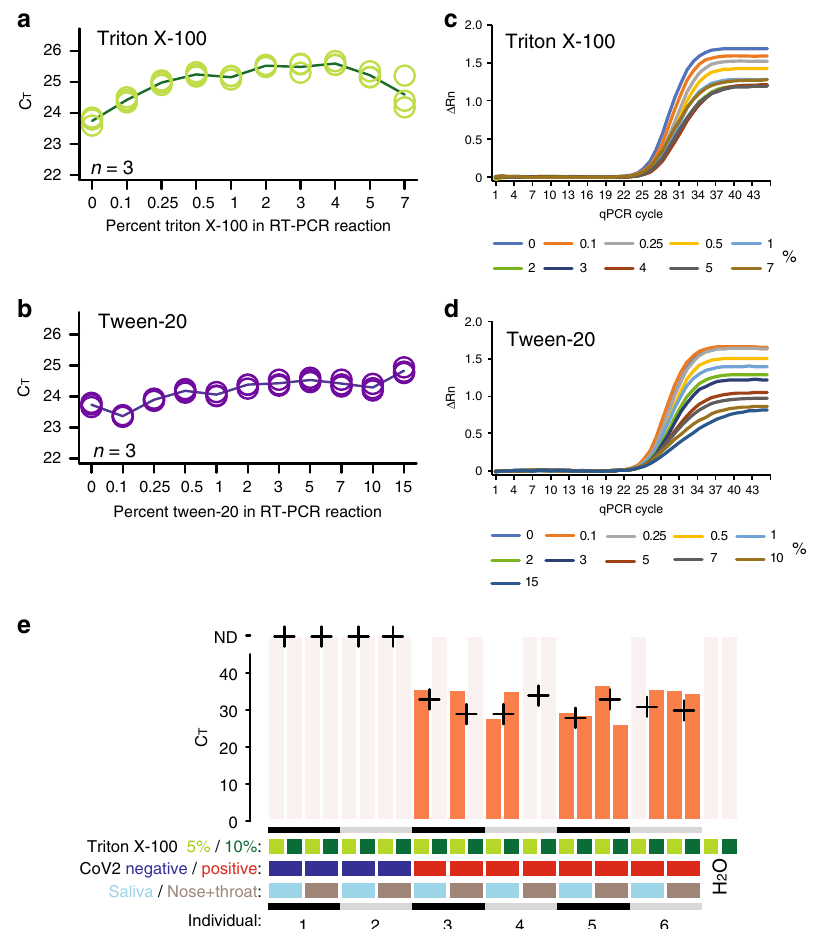
Fig. 7 Direct SARS-CoV-2 RT-PCR detection from lysate. a , b Line charts of C T values (y-axis) from RT-qPCR performed with different percent (vol./vol.) Triton X-100 ( a ) or Tween-20 ( b ) ( x -axis) in the reaction. c , d Ampli fi cation plots showing normalized reporter value ( Δ Rn, linear scale) as a function of qPCR cycle for the experiments and samples described in ( a , b ). e Barplots of C T from SARS-CoV-2 RT-PCR using the N1 primer-probe set performed directly on lysed donor samples after storage and freeze thaw from self-sampling (saliva or nasal + throat swab suspensions taken with cotton tipped wooden sticks) without puri fi cation. Percent Triton X-100 indicates the percentage detergent in the sample (half concentration in the RT-PCR reaction). Crosses indicate C T values from diagnostics performed on extracted RNA from fresh